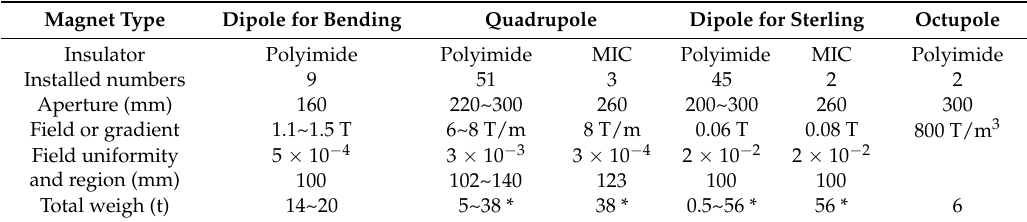
Table 5. Specifications of magnet used in beam transport for spallation neutron